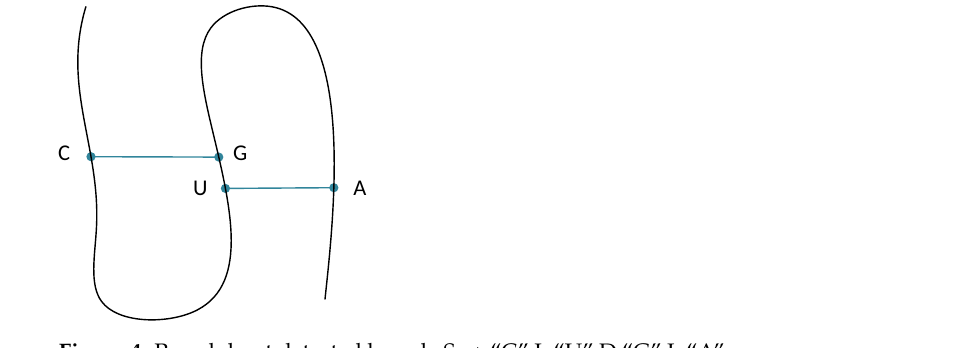
Figure 4. Pseudoknot detected by rule S → “C” L “U” D “G” L “A”. L is the non-terminal symbol that will produce sequences of bases forming the two interior loops of the pseudoknot, i.e., sequences of bases between C and U as well as between G and A. Non-terminal L may produce strings belonging to set ( T ) ∗ (cid:54) = ∅ , where T is the set of terminal symbols, and ∅ is the empty set. Hence, L may produce strings of length greater than zero as A, UA, CCGGAU,